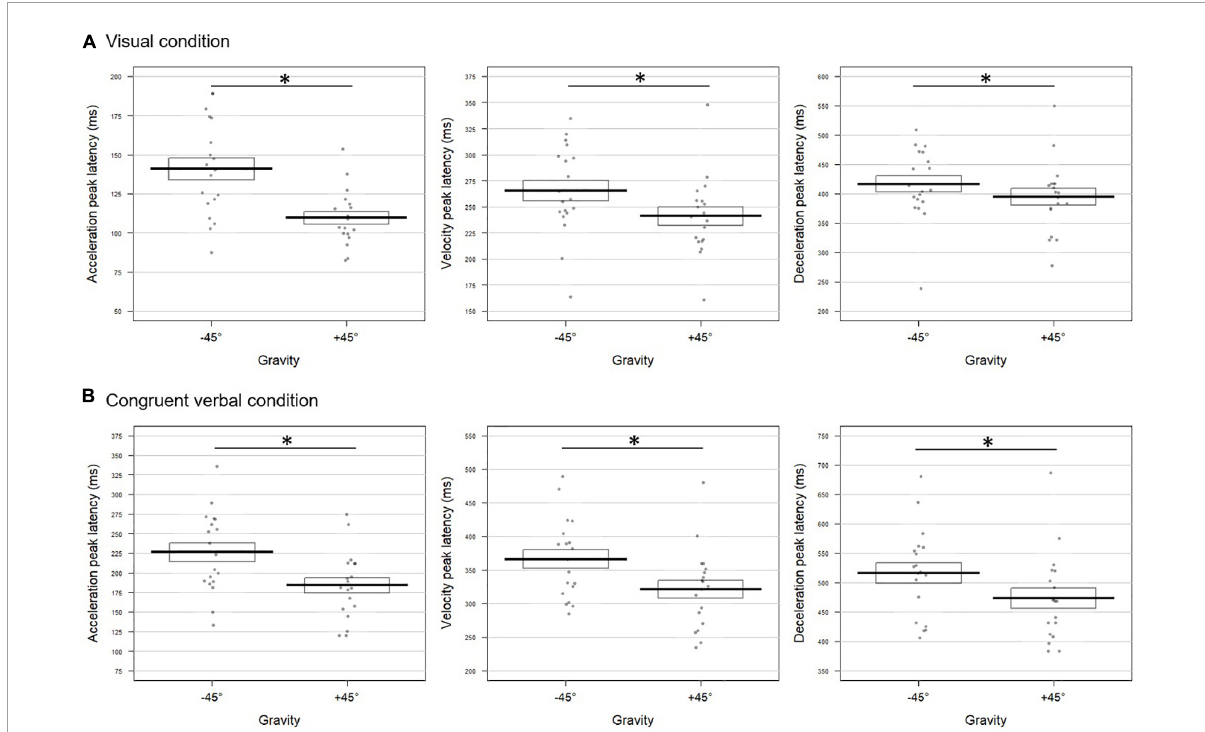
FIGURE4 Gravity effect on the movement tangential profile for (A) visual and (B) verbally congruent instructions in Experiment 2. Latencies of the acceleration (left panel), velocity (middle panel), and deceleration (right panel) peaks are reported for movements toward –45 ◦ and +45 ◦ targets (see Figures 2 , 3 for conventions; ∗ indicates a significant difference between conditions). (A) For visually cued targets, acceleration, velocity, and deceleration peaked earlier in the +45 ◦ than in the –45 ◦ condition ( t = –10.07; p = 0.0004; t = –6.56; p = 0.0004; and t = –5.16; p = 0.0004, respectively). (B) Upon congruent verbal instructions, the three kinematics parameters also occurred earlier when participants pointed toward +45 ◦ compared to –45 ◦ targets (acceleration: t = –4.79; p = 0.0012; velocity: t = –5.17; p = 0.0008; deceleration: t = –3.59; p =